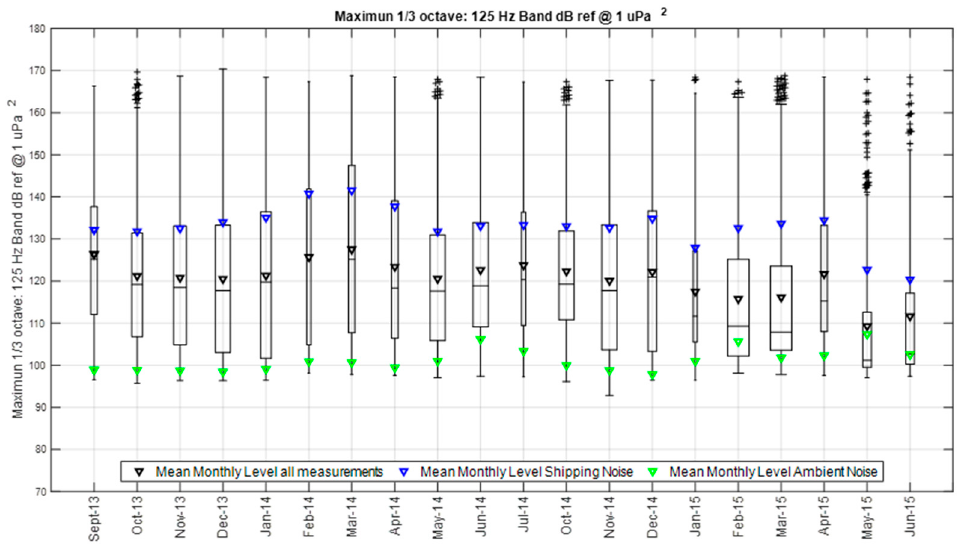
Figure 9. Monthly average evolution of the maximum of the 1/3 octave band at 125 Hz. The mean monthly values of shipping, other anthropogenic, and natural noise measurements are represented with blue, black, and green triangles, respectively.